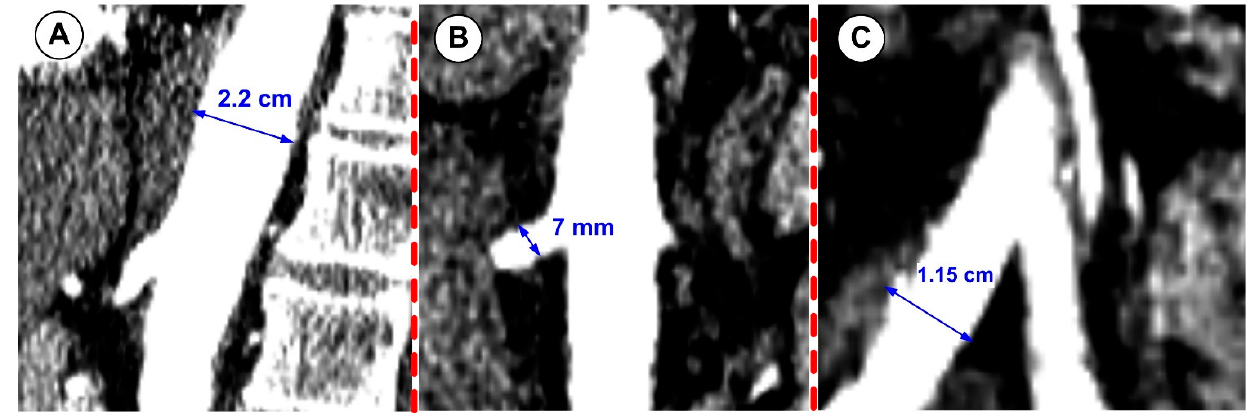
Table 1. Reconstructed arteries’ geometrical parameters.